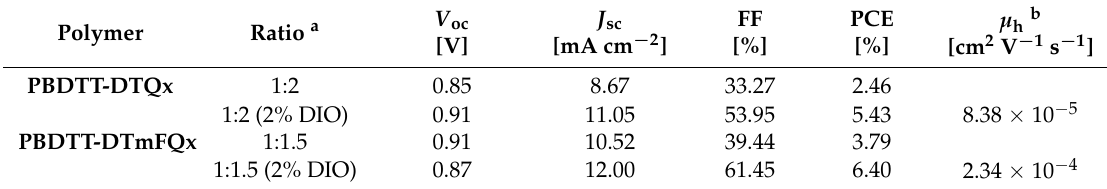
Figure 5. Current density–voltage ( J–V ) curves of the optimized hole-only copolymer/PC 71 BM devices. Table 3. Photovoltaic properties of the copolymer/PC 71 BM-based polymer solar cells (PSCs) at optimized conditions under illumination of AM 1.5G, 100 mW/cm 2